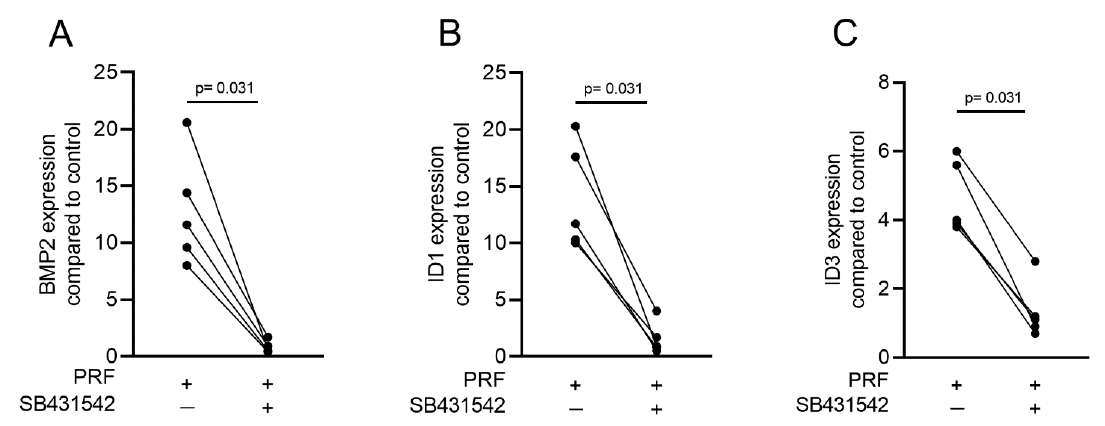
Figure 4. A TGF-β receptor I kinase antagonist blocks BMP2 and its corresponding genes. Gingival fibroblasts were stim- ulated with PRF lysates in the absence or presence of the TGF-β receptor I kinase antagonist SB431542 (10 µM). PCR analysis for ( A ) BMP2, ( B ) ID1, and ( C ) ID3 gene expression is presented. n = 5. Statistical analysis was performed with a two-tailed t -test.